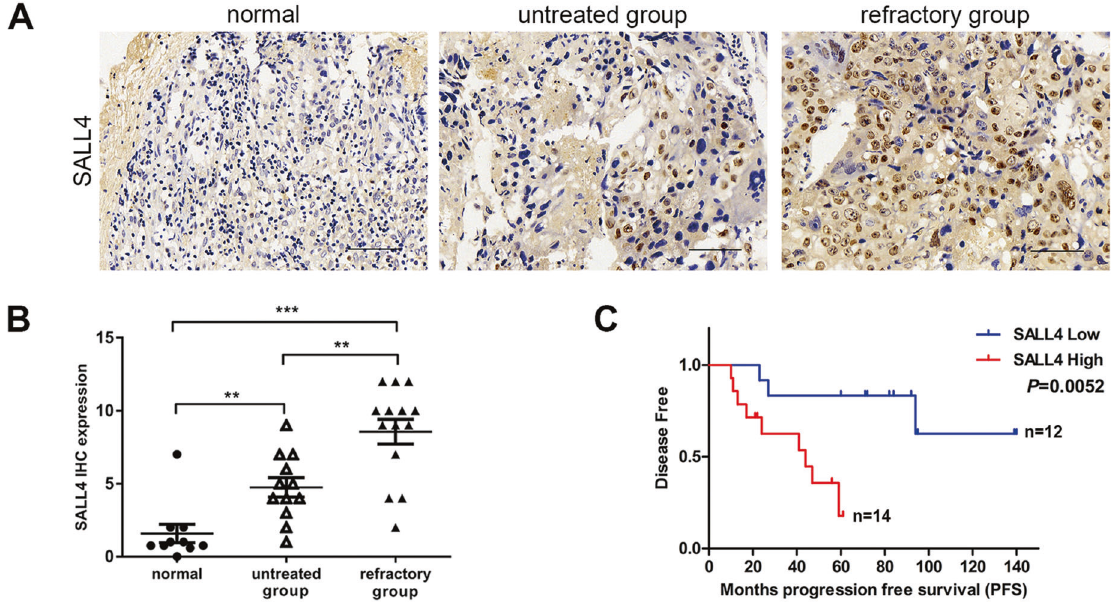
Fig. 1 SALL4 overexpression is correlated with choriocarcinoma prognosis. A SALL4 protein levels in 10 normal and 26 choriocarcinoma tissues by using IHC (magni fi cations: ×400). B SALL4 expression in 10 normal and 26 choriocarcinoma tissues according IHC scores. C Progression-free survival time between low-SALL4-expression group and high-SALL4-expression group in choriocarcinoma tissues. Data represent mean ± SD from at least three independent experiments. ** P < 0.01, *** P <